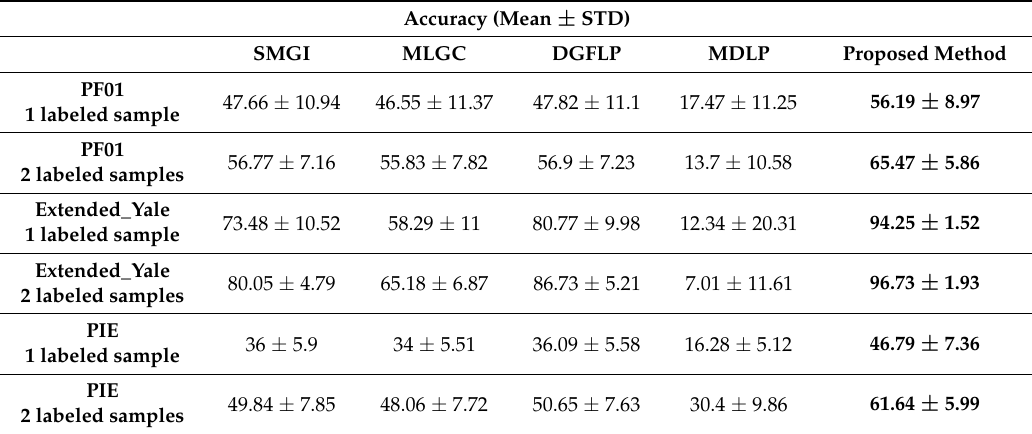
Table 5. Mean accuracy and standard deviation of the proposed method compared with other methods on LBP feature descriptor.